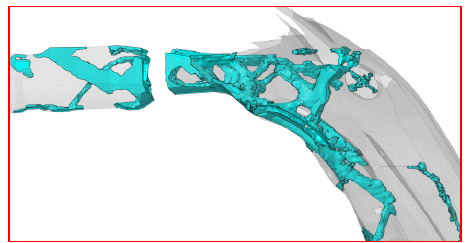
Figure 15. Reticular structure on Node D.